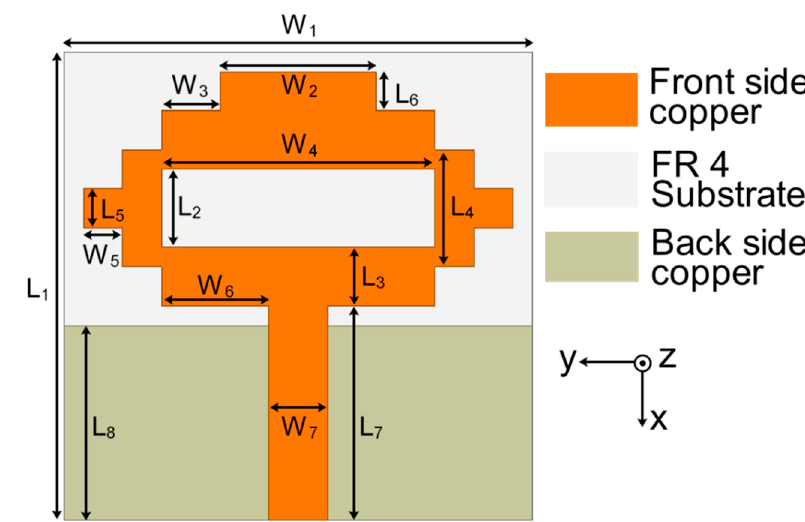
Figure 1. Configuration of single antenna.